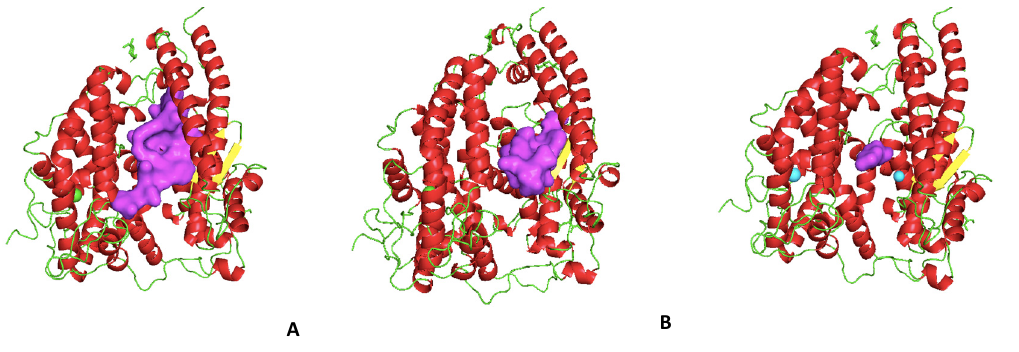
Figure 3. Molecular docking of selected peptides from Table 2 to human ACE2; in purple, the peptide configuration and position upon docking. ( A ) Thunnus obesus ; ( B ) Palmaria palmata ; ( C ) Undaria pinnatifida .